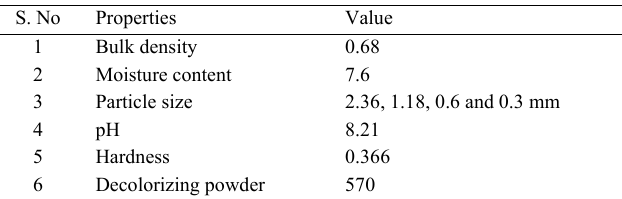
Table 1: Characteristics of bamboo activated carbon